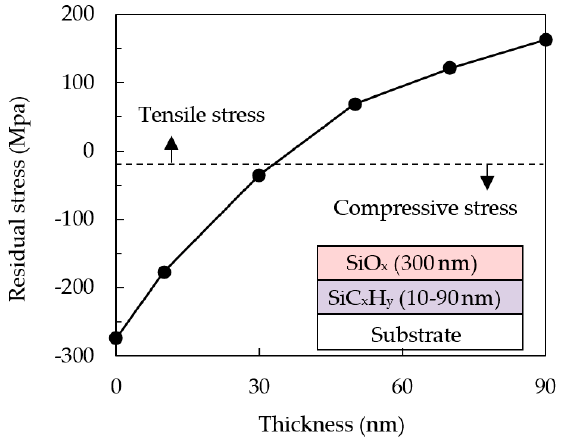
Figure 2. Residual stress of the SiO x /SiC x H y films with different SiC x H y thicknesses.